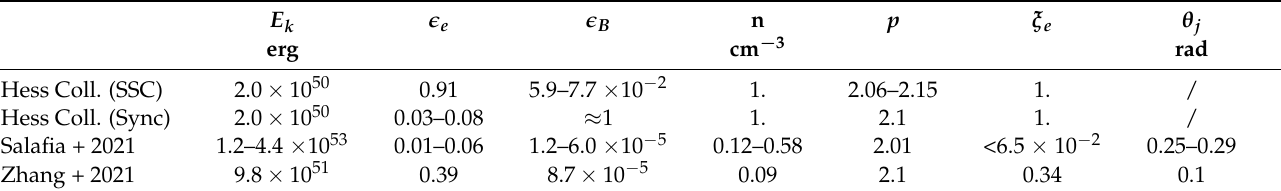
Table 3. Parameters for modeling of